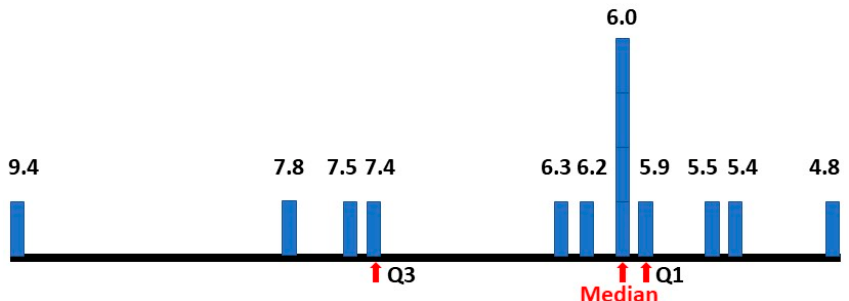
Figure 14. Percentage prevalence estimates of female ASD. Figure 13. Percentage prevalence estimates of female ASD. Four methods were used to calculate the median value of P(ASD) as 0.060.